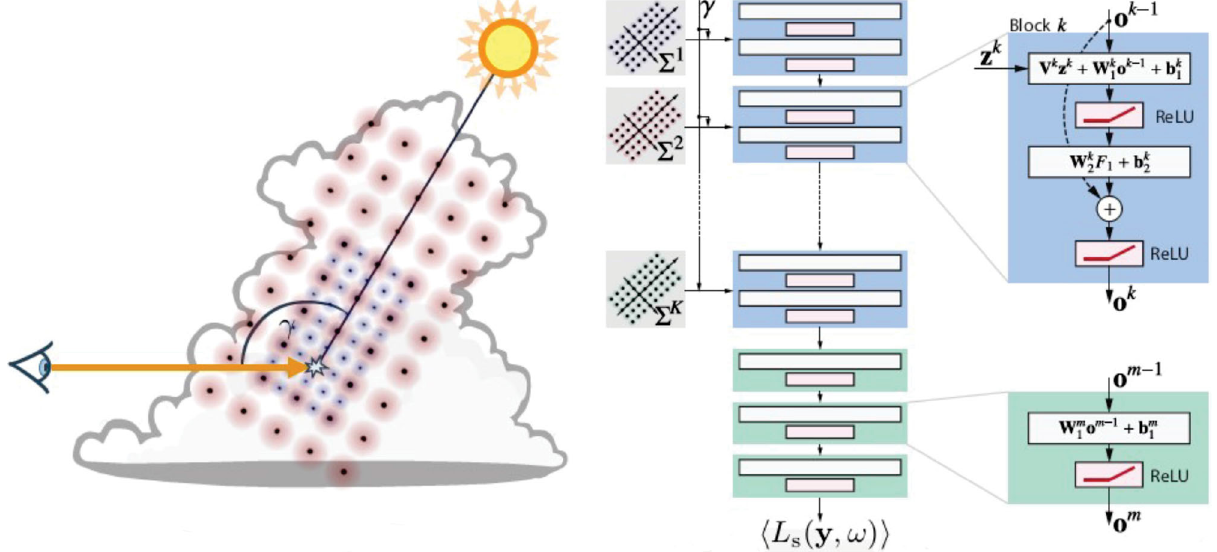
Fig. 16 Stencil grid (left) and progressive training network (right). Reproduced with permission from Ref. [64], c (cid:2) The Author(s) 2017.